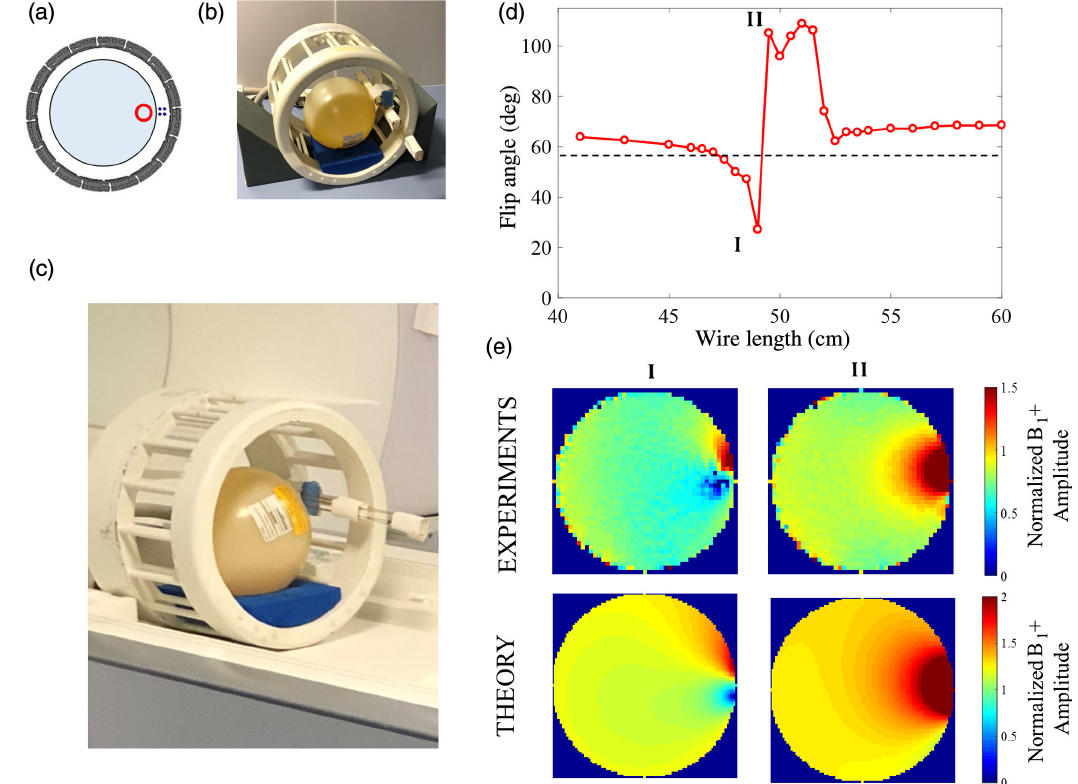
FIG. 4. (a) Schematic view of experimental configuration inside the 7 T MRI: birdcage coil (dark gray), HMA (4 blue rods), and oil phantom ϵ r ¼ 3 . 4 (light gray). (b),(c) Pictures of the experimental setup, positioning of the HMA in the birdcage coil and into the MRI scanner. (d) Average flip-angle magnitude in the ROI [red circle in (a)] as a function of the HMA length. The dashed line indicates the reference value (without HMA). (e) Top: Normalized axial B þ 1 maps measured for two lengths of interest, namely, 49 and 49.5 cm. Each corresponds to the Kerker conditions with an enhancement or cancellation of the B þ 1 field close to the HMA. Bottom: Normalized field maps obtained from the theoretical calculations for the two Kerker conditions. HMA length from left to right at the calculated Kerker conditions (49.6 and 49.8 cm, respectively). A circular mask is applied to reproduce the phantom